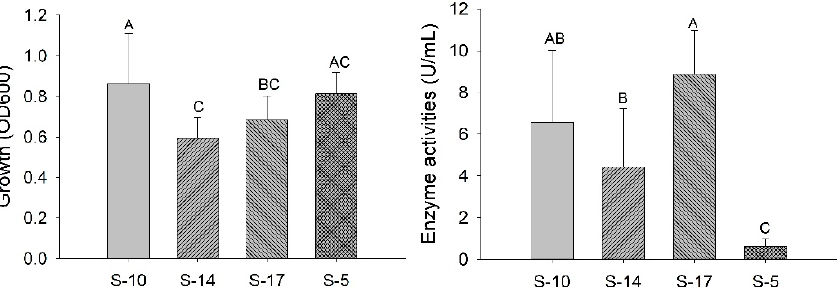
Figure 2. Bacterial growth and enzyme activity produced by isolates. The bar represents the mean of bacterial growth and enzyme activity. The statistical analysis was performed with one-way ANOVA followed by a post hoc Tukey comparison test. Letters above each bar represent statistical significance at p < 0.05.